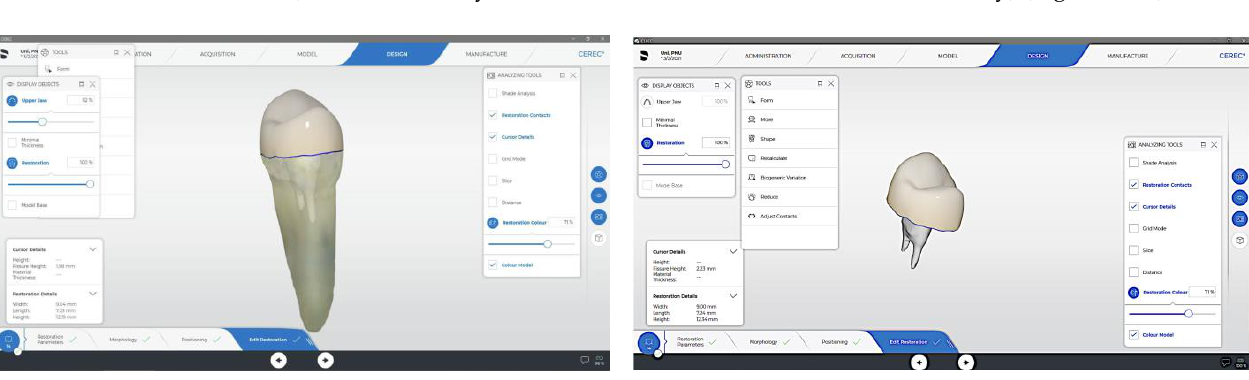
Figure 3. Primescan generated design of endocrown with 3 mm intraradicular extension.